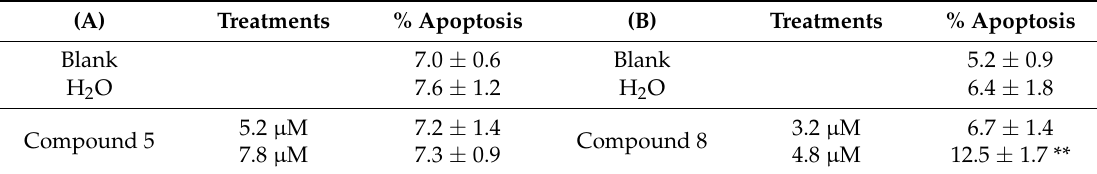
Table 3. Levels of apoptosis in non-small cell lung cancer (NCI-H460) cells following 48 h treatment with compounds 5 (A) and 8 (B).